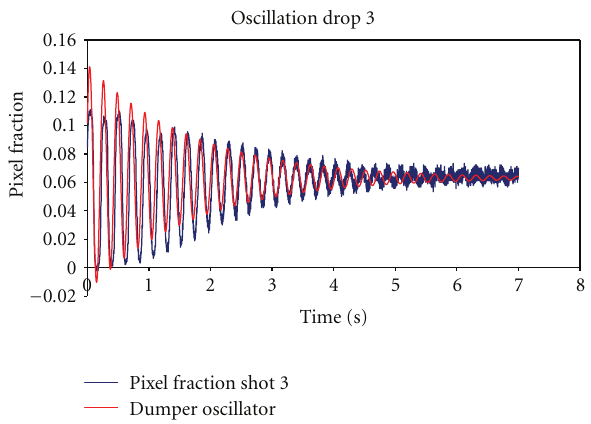
Figure 2: The graph shows the under-dumping decay attained for the fraction of the i -pixel occupied by the beam (i.e., blue line C 2 ) used for the Montagnole experiment. Red line depicts the theoret- ical dumper oscillator calculated from the parameters of Table 1.